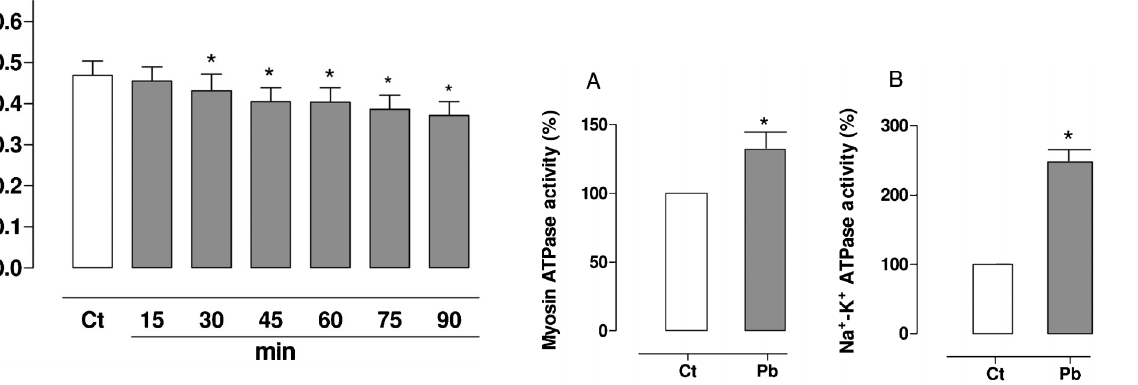
Figure 3. Myosin ATPase activity ( A ) and Na + ,K + -ATPase activity ( B ) of control (Ct) and lead (Pb)-exposed animals. Results are reported as means ± SE for 6 animals. *P , 0.05 (Student t